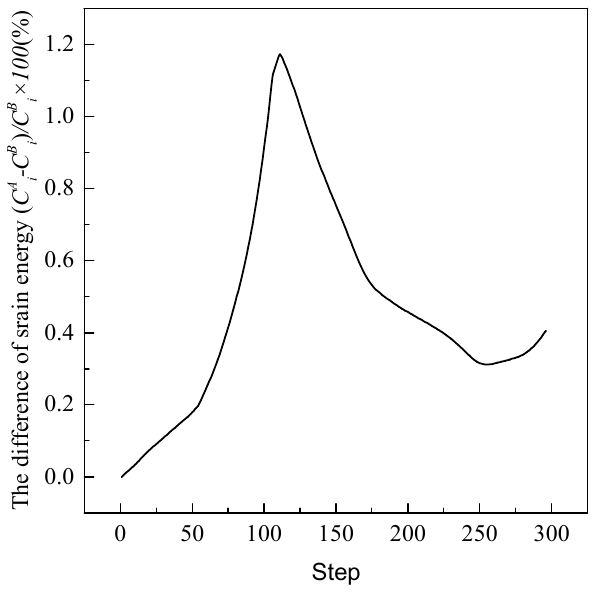
Figure 12. The change ratio of the strain energy.